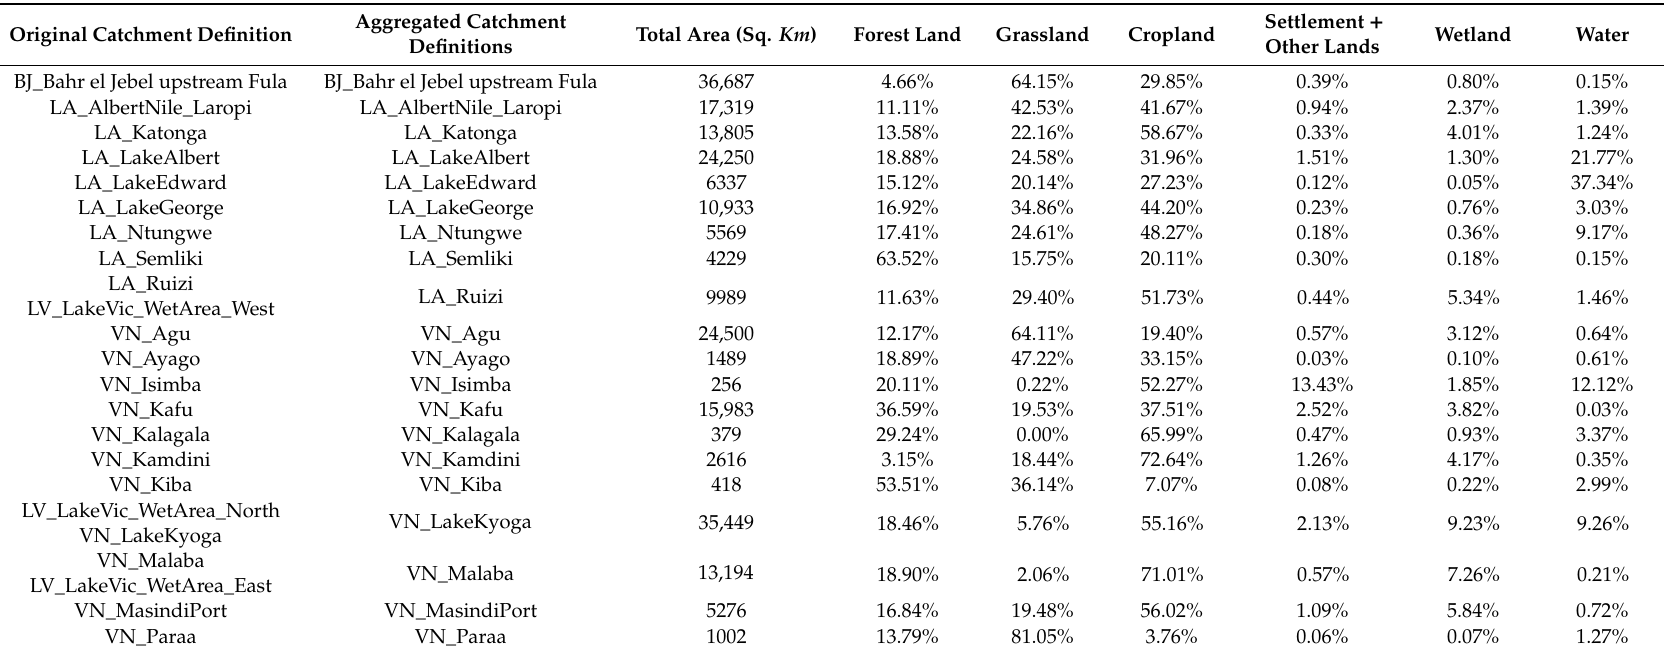
Table A1. Land cover types in the study